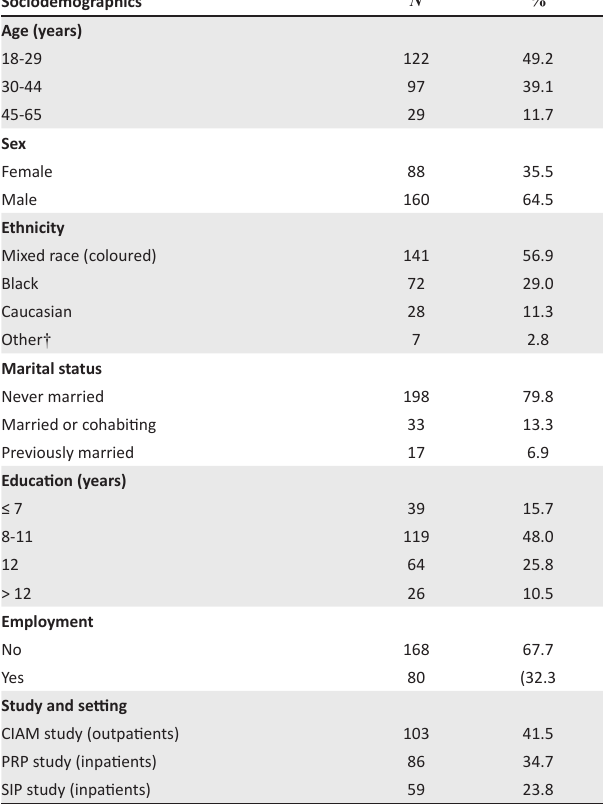
TABLE 1: Sample sociodemographic characteristics ( N = 248). Sociodemographics